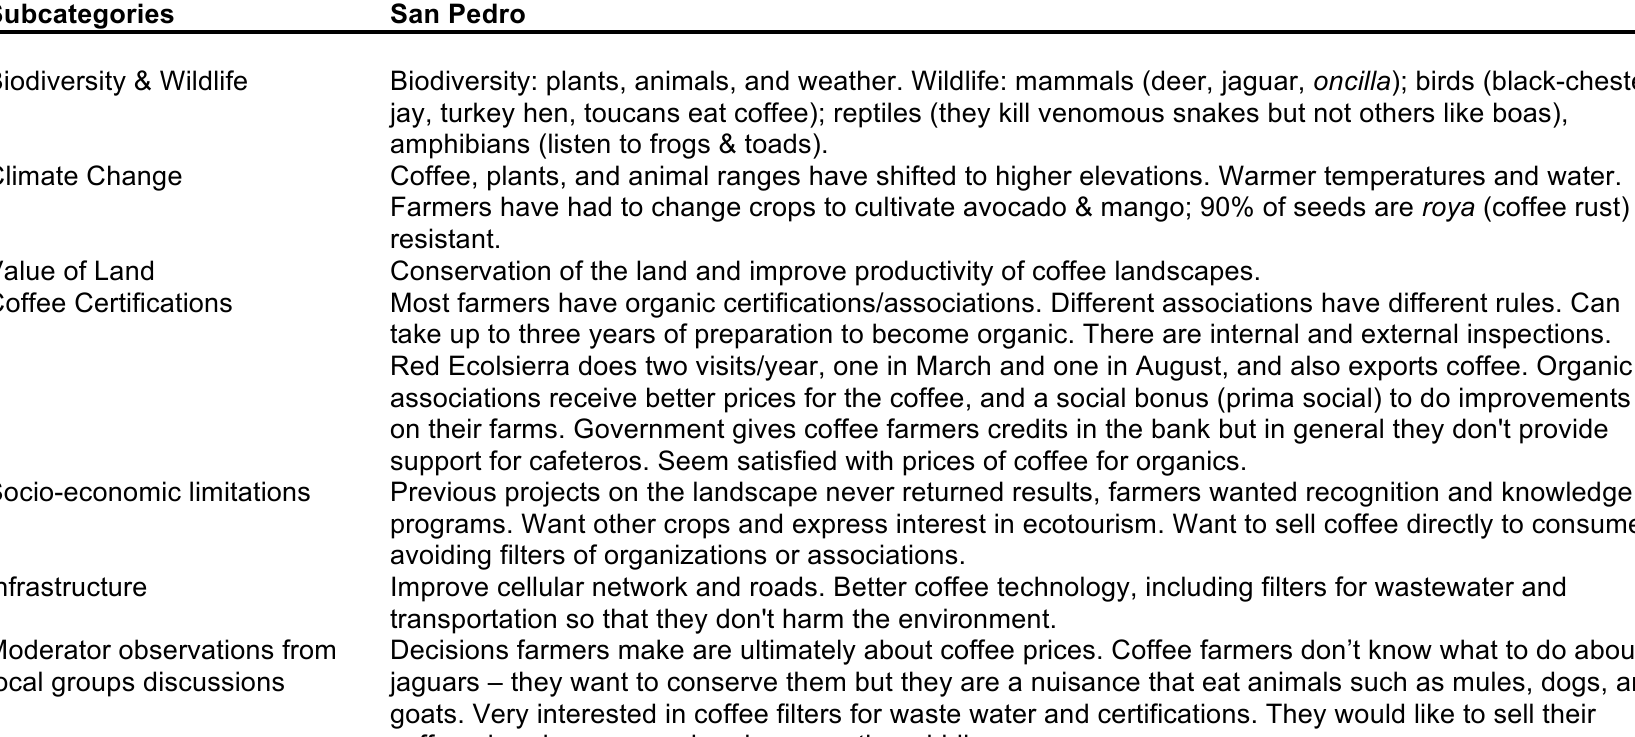
Table A2.4 The community of San Pedro (n=10) presented here.